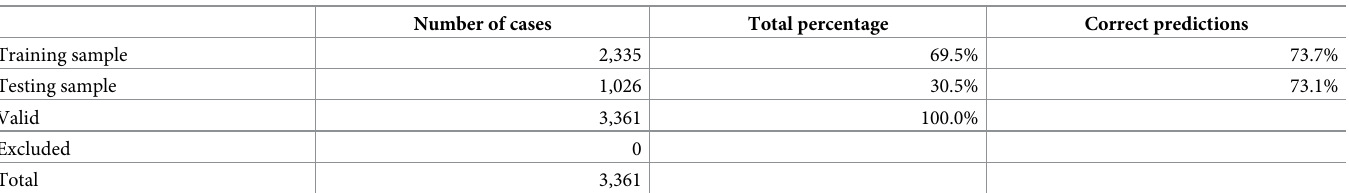
Table 3. ANN case processing summary–Model 1a.